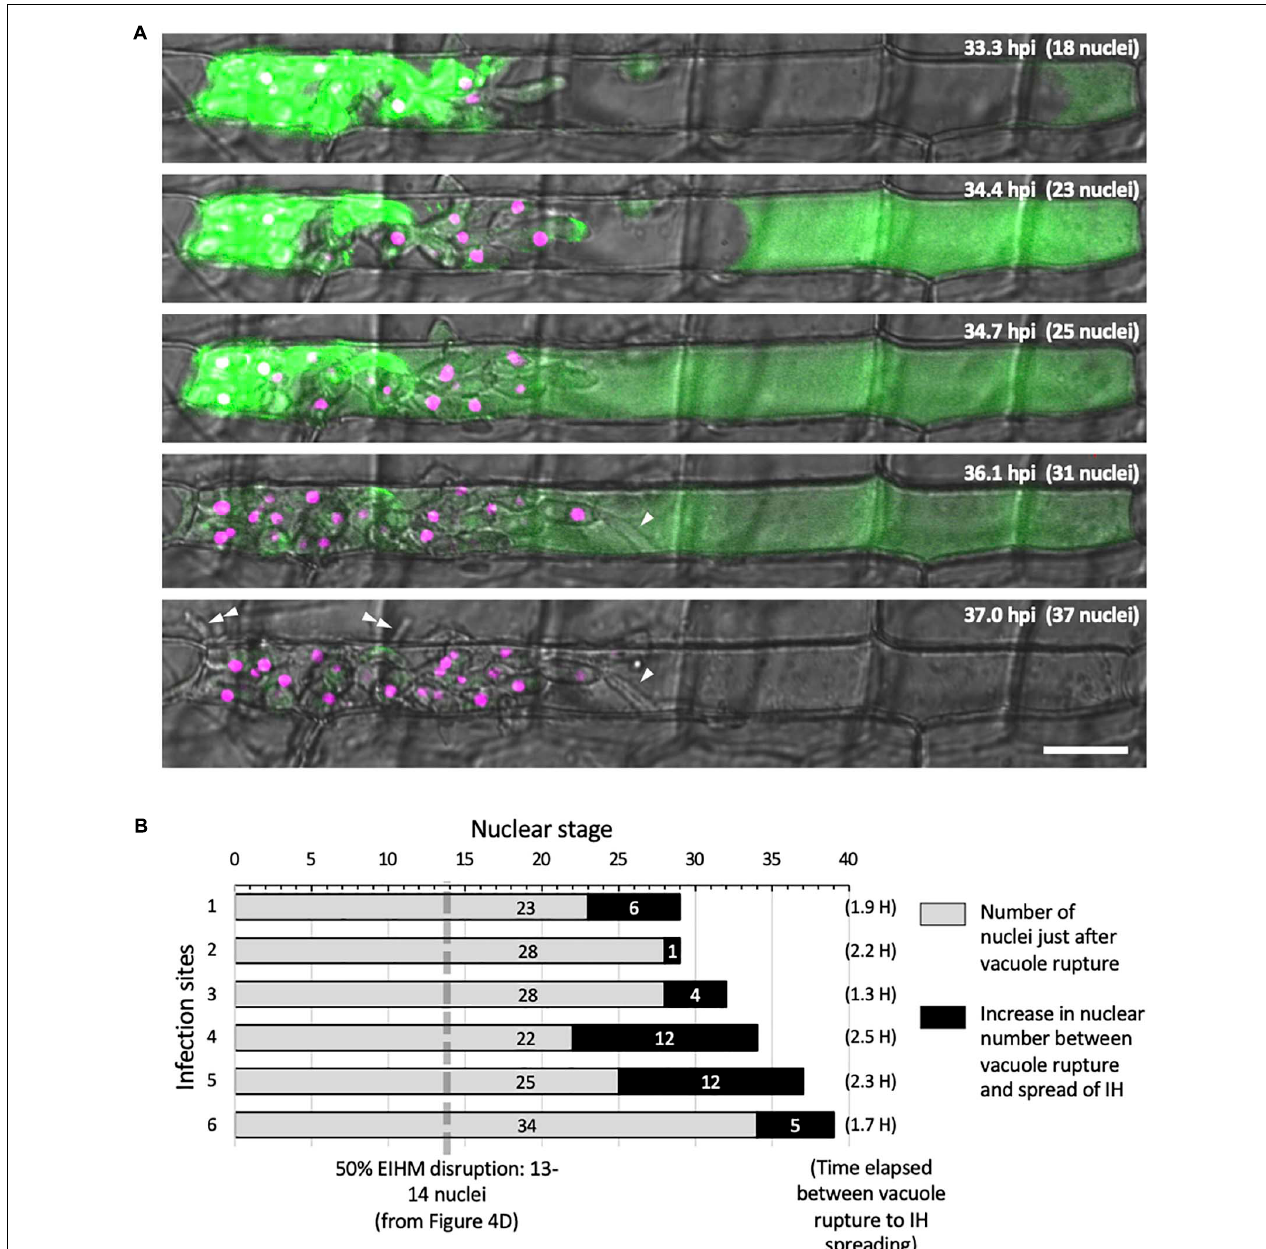
FIGURE 6 | IH morphology changes after host cell death. (A) Representative time-lapse of M. oryzae CKF2187 expressing sec-GFP (green) and nuclear tdTomato (magenta) invading a rice cell from 33 to 37 hpi. Shown are single plane confocal images of merged bright-field and fluorescence. Nuclear stage is indicated in the upper right-hand corner together with hpi. Growth of IH become more filamentous after disruption of the vacuole (white arrowheads). The first IH to cross into the next host cell (double white arrowheads) originated from IH that had grown to be densely packed against the host cell wall before vacuole rupture. Bar = 20 µ m. (B) Graphical summary showing six time-lapsed CKF2187 infections ranging from 32 to 40 hpi. Shown are the nuclear stages when vacuole rupture was observed (gray bars) and the relative increase in nuclear stage when IH were observed to spread into neighboring host cells (black bars). The time elapsed between vacuole rupture and IH spreading is shown in parenthesis, corresponding to the black bars. For additional context, the nuclear stage at which 50% EIHM disruption occurred (13–14 nuclei; Figure 4D ; n = 390) is denoted by the dotted gray